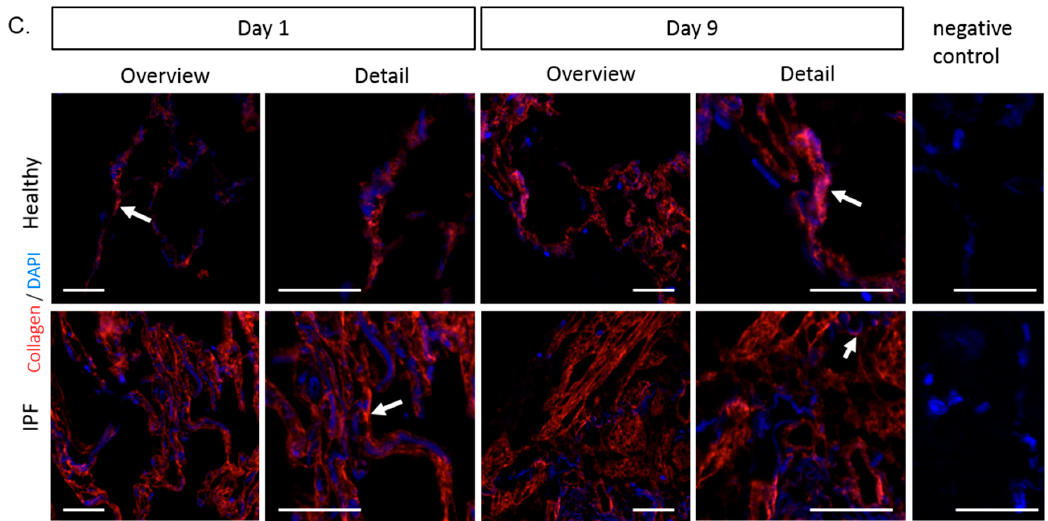
Figure 5. Synthesis of basement membrane proteins in repopulated scaffolds. ( A ) Heatmap of basement membrane (BM) proteins over time. Repopulated scaffolds as group mean heavy intensities for each time point (biological replicates n = 4, technical replicates n = 2). With Student’s t -test, significantly differentially expressed proteins are marked with *. Perlecan = Basement membrane-specific heparan sulfate proteoglycan core protein. Production of significantly different basement membrane proteins in repopulated IPF and healthy scaffolds. Protein intensity shown as mean heavy intensity ( B ) over time for each group with SD. Student’s t -test with Benjamin–Hochberg corrected p -values for significance between patient groups of the same time point with p -values * p < 0.05. Blue = Healthy, Red = IPF. ( C ) Antibody labeling of repopulated scaffolds, at day 1 and day 9 of culture, showing collagen type VI ( α 1) (red) with DAPI staining (blue). Images of collagen VI staining, illustrate newly synthesized protein and original scaffold composition, with arrows exemplifying positive staining. Scale bar = 50 µm.